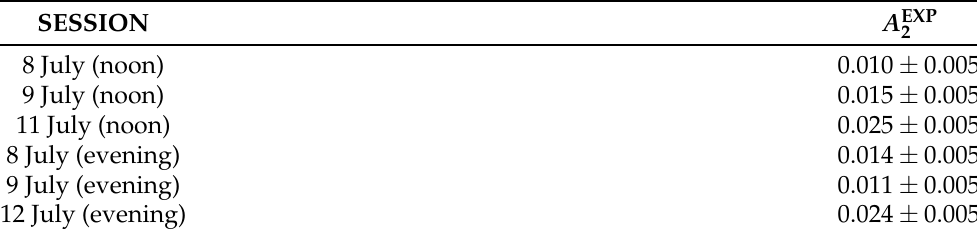
Table 1. The second-harmonic amplitudes for the six experimental sessions of the Michelson–Morley experiment. The table is taken from [37].